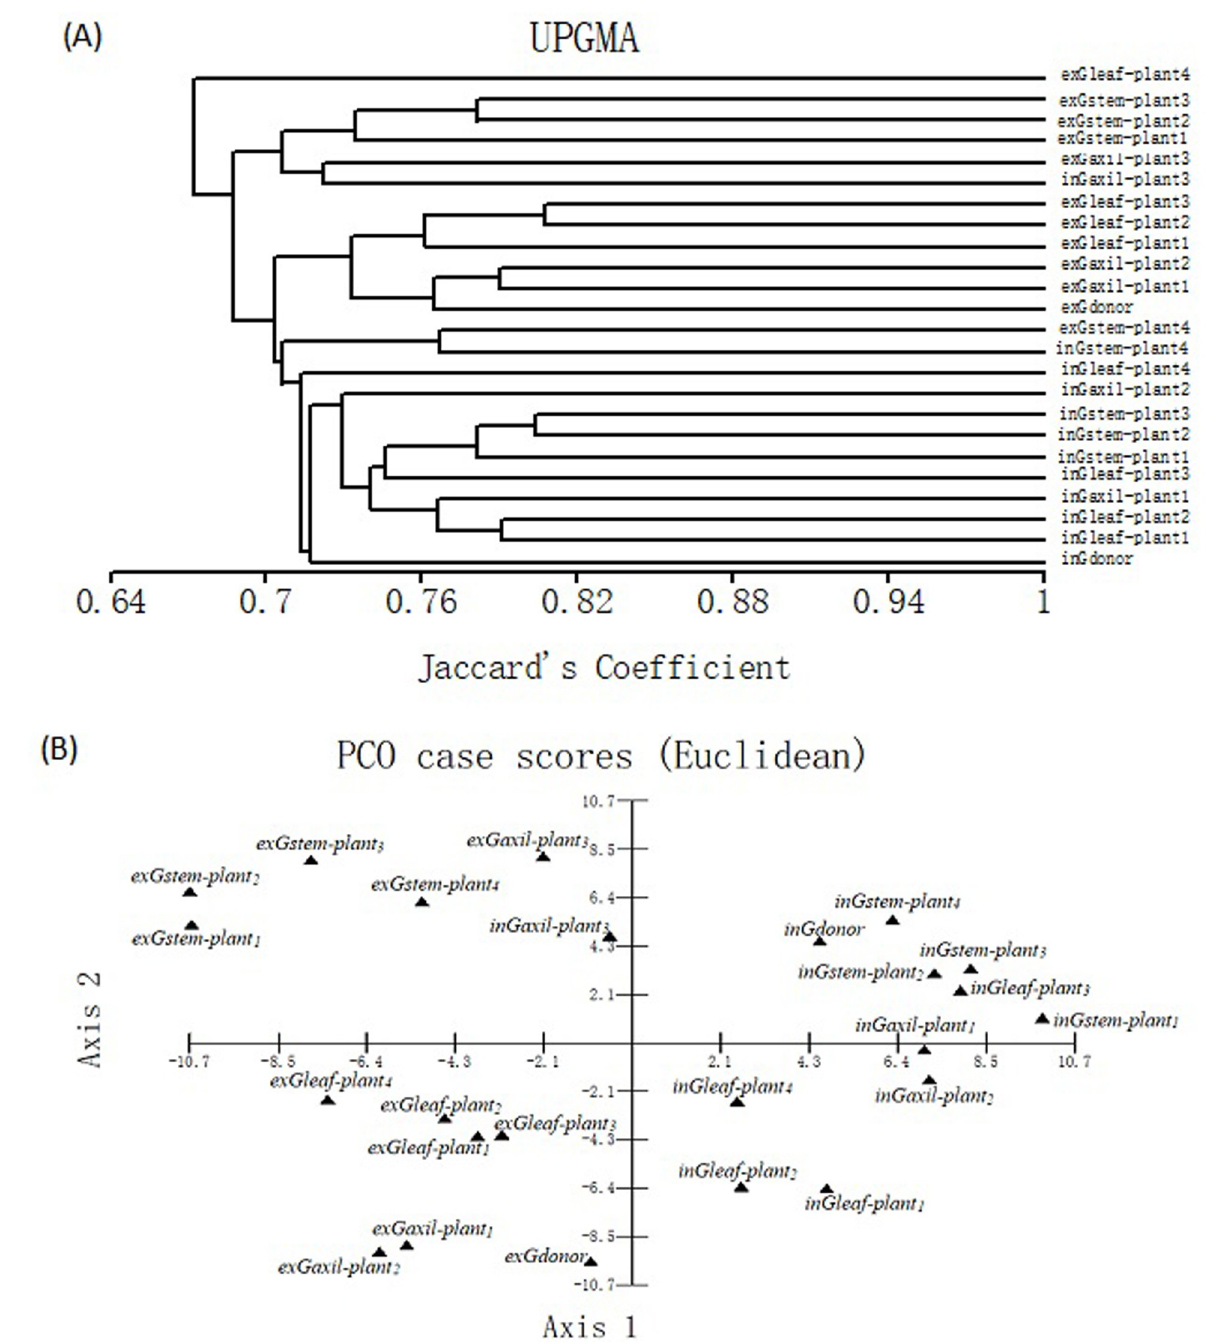
Fig 5. Dendrogram illustrating coefficient similarities among samples in L . ruthenicum G group by the UPGMA cluster analysis based on the MSAP profiles (A), and associations among the samples in G group revealed by PCA (B).